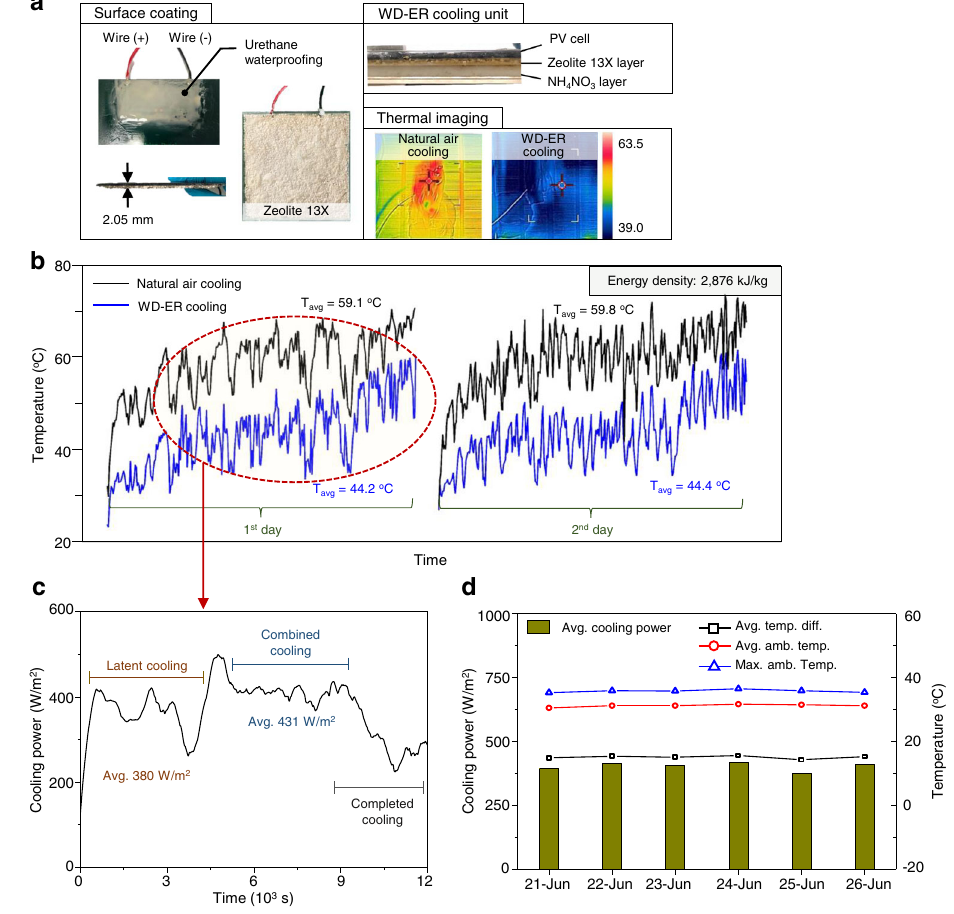
Fig. 6 | Practical application of water desorption-driven endothermic reaction (WD-ER) cooling unit for photovoltaic (PV) cell. a Images of PV cell with WD-ER unit. b TemperaturevariationofPVcellduringaday. c Netcoolingpowerdensityof